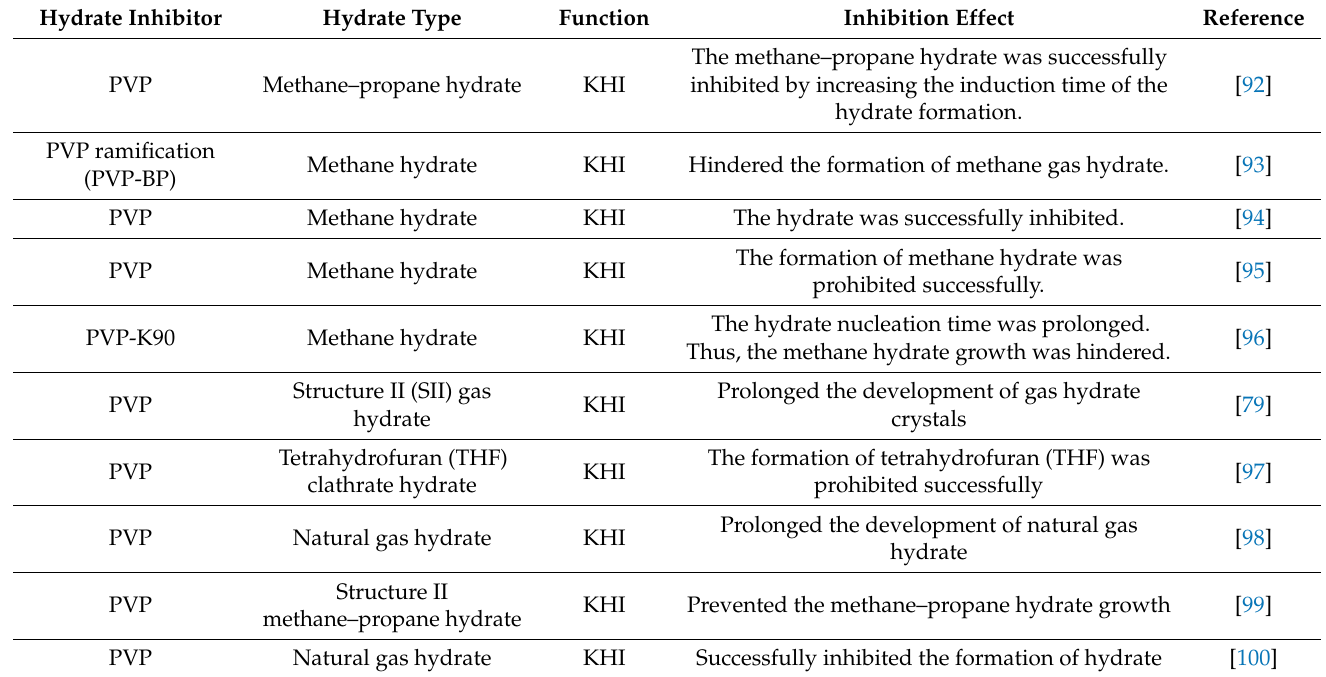
Table 4. The inhibition effect of several PVP inhibitors on distinct types of